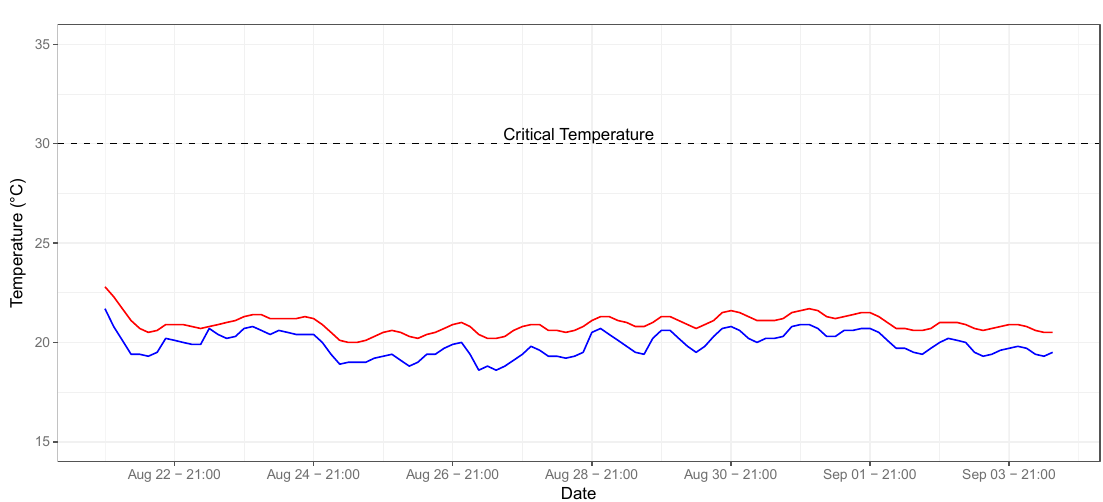
Figure 3. Time series showing the internal temperatures of the improved Zeepot Clay (blue line) vs. Zeepot Cementsand (red line) designs. The critical temperature above which the potency of thermotolerant rabies vaccines decrease is indicated by the dashed